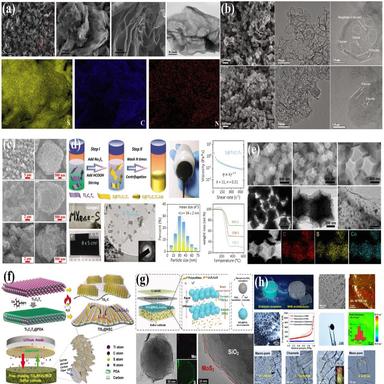
(a) SEM images of NG/S composite, TEM of NG/S, and EDS mappings of S, C, and N Copyright 2018, Elsevier; (b) SEM and TEM images of PSSN and PSSN/S Copyright 2018, Royal Society of Chemistry; (c)SEM images of SiO2-RGO composite, HGSand S-HGS composite Copyright 2019, Elsevier; (d) Schematic preparation and optical image of S@Ti3C2Tx ink, showing its viscous nature, Handwriting on Celgard membrane and doctor-blade casting on Al foil using the S@ Ti3C2Tx ink, TEM i